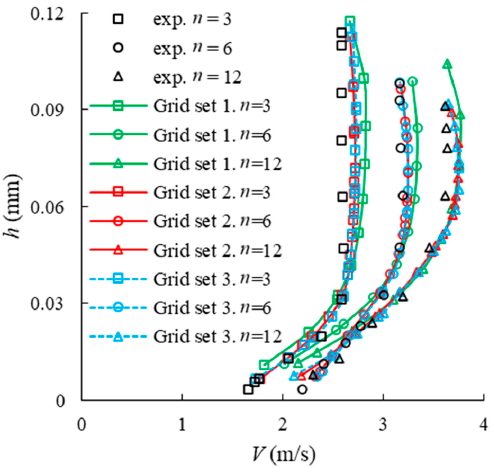
Figure 2. Comparisons of velocity profiles on various steps between our numerical simulation and experiment data from Hunt et al.